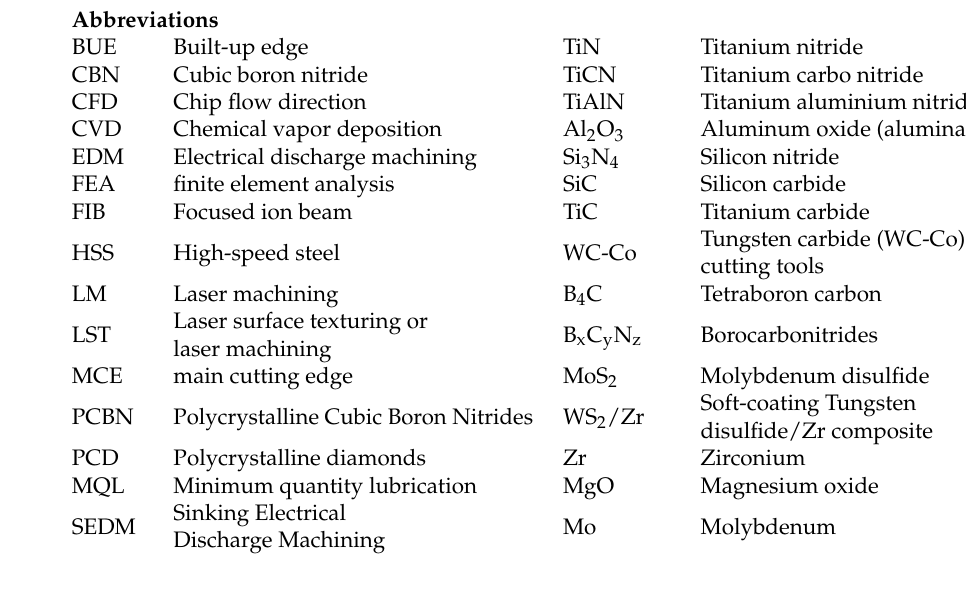
Table A1. Abbreviations, Symbols and